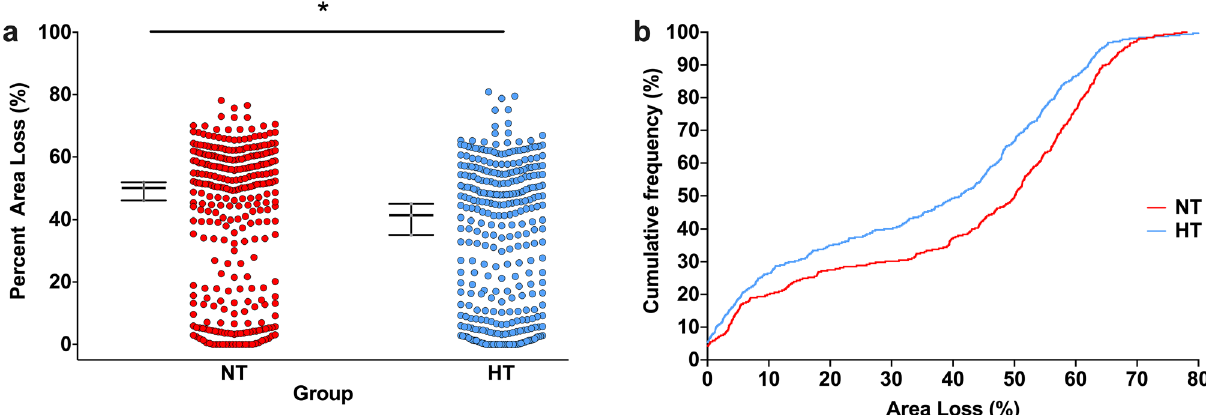
Figure 1. Hypothermic neuroprotection. ( a ) Scatter plot of percent area loss in the NT (n = 305) and HT (n = 317) groups. The median with 95% CI is plotted adjacent to each scatter. Across the 21 experiments, median (95% CI) area loss in was 50.1% (46.0–51.9%; n = 305) in the NT group, and 41.3% (35.1–44.9%; n = 317) in the HT group. *Denotes significant neuroprotection ( p < 0.001). ( b ) Cumulative frequency plot from the NT (n = 305) and HT (n = 317) groups, with each observation resulting in a proportional increase in the y-axis. A relatively uniform degree of neuroprotection is seen across the whole range of injury severity, particularly between 10 and 60% area loss.